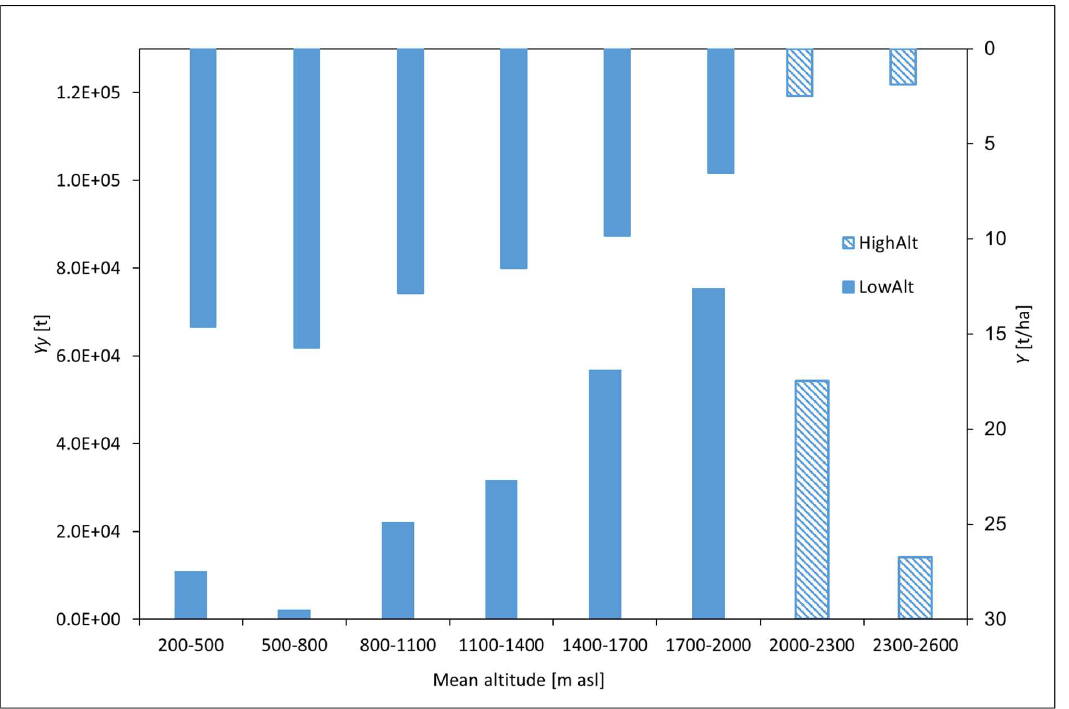
Figure 5. Pasture productivity: simulation of total production of pasture species Y y (left ordinates axis) and specific production Y (right ordinate axis, upside down) as per altitude belts for year 2017, considering variable GS. Zone HighAlt and zone LowAlt.